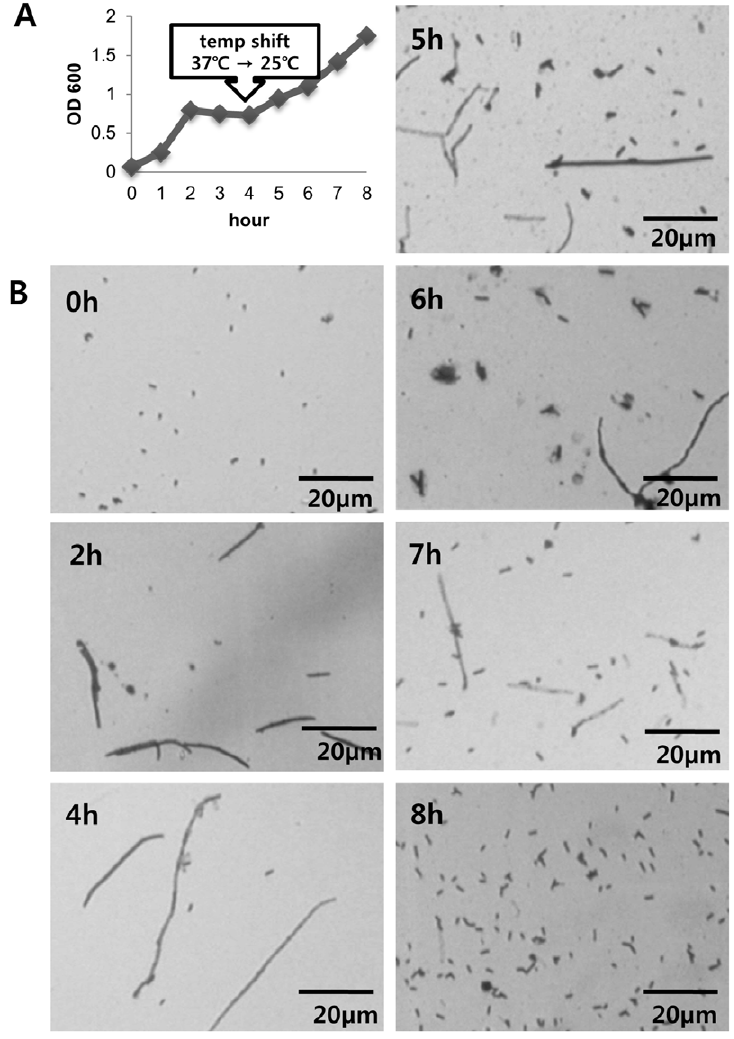
Figure 3. The filamentous growth of MG1655/pCnuK9E can be reversed to normal growth. MG1655/pCnuK9E cells grown in LB liquid medium at 37 u C became filamentous 4 h after induction of CnuK9E (B, 4 h). When the culture was transferred to 25 u C and continued, cells resumed normal growth 4 h after the temperature shift (B, 8 h). The cell growth of this experiment is presented as OD 600 vs. growth time (A).